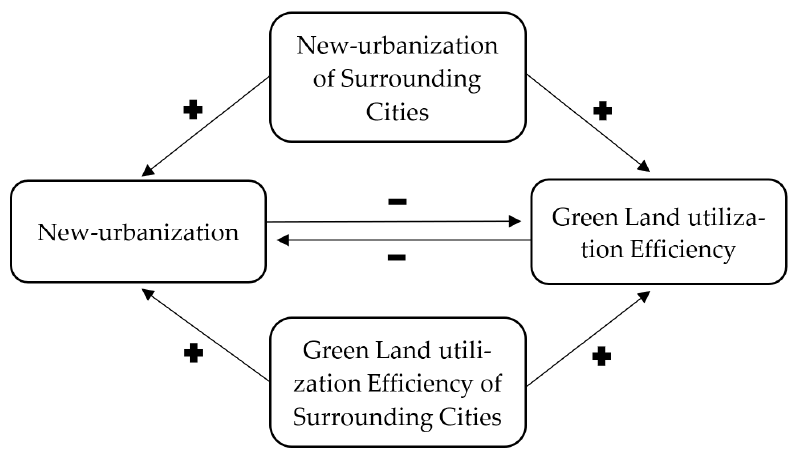
Figure 2. Interactive and spillover mechanism of new-urbanization and urban green land utilization efficiency in China.